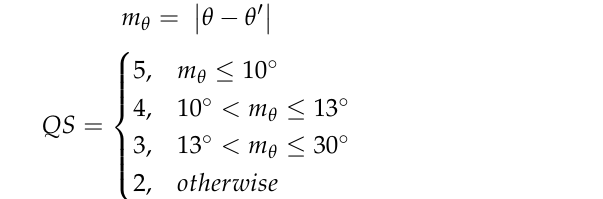
If the number of buildings is two, the azimuth comparison measure ( m θ ) is used that finds the azimuth difference between the connection lines generated between the centroids of the buildings and calculated with Equation (17) (Figure 14) and the scores are assigned by Equation (18).